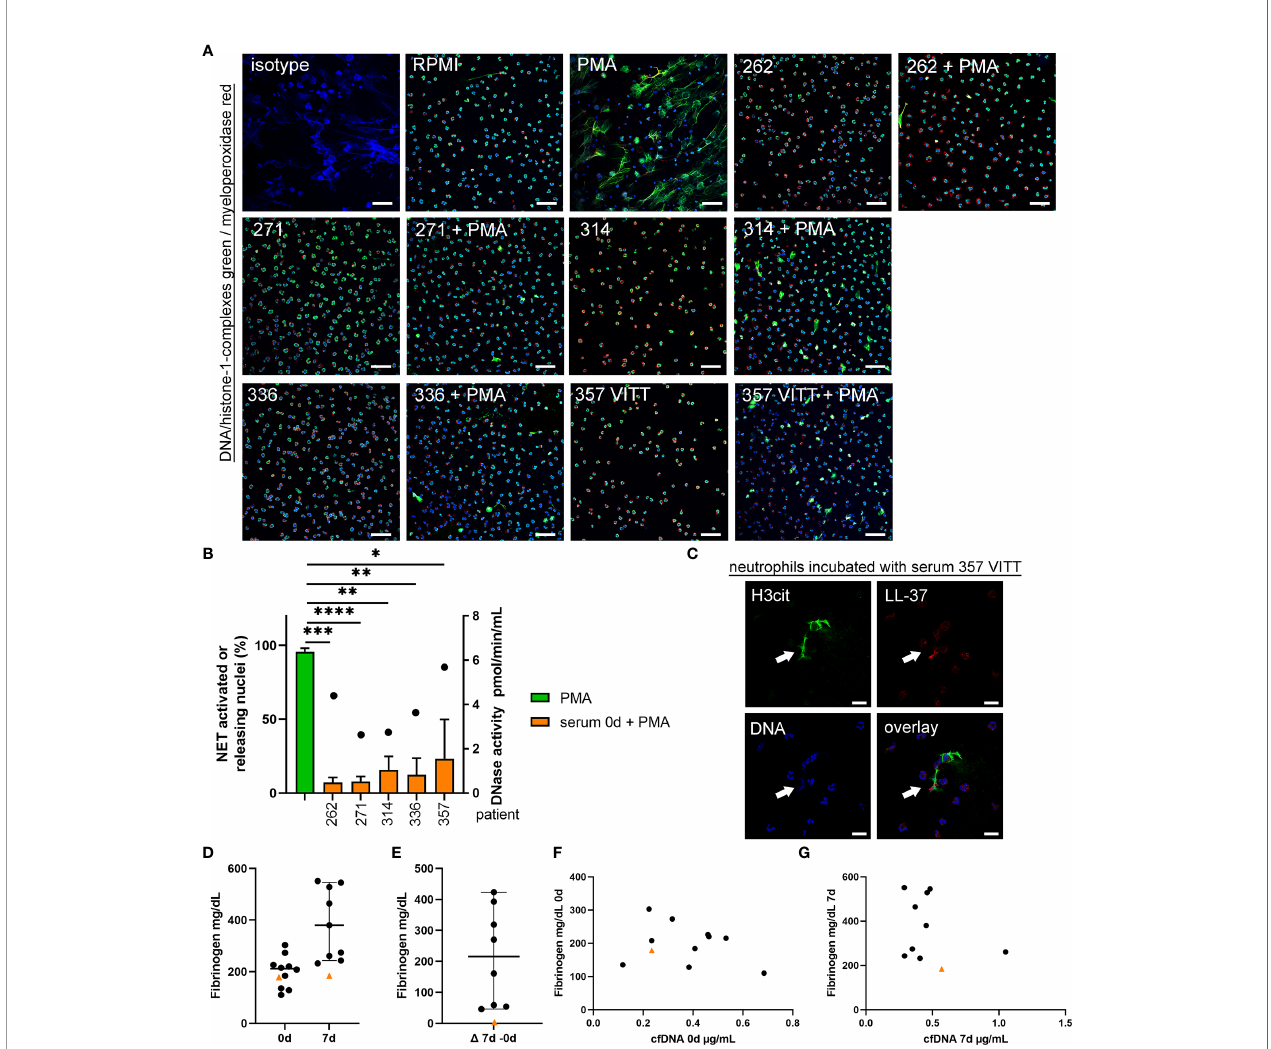
FIGURE 6 | Serum from VITT and control patients does not induce NET-formation, but NET-release from activated neutrophils is less inhibited in VITT-patient. (A) Human blood-derived neutrophils were incubated with serum from onset of four control patients and the VITT-patient in presence and absence of the ROS- dependent NET inducer PMA. Samples were analyzed for NETs (blue = DNA, green = DNA-histone-1-complex, red = myeloperoxidase) by confocal immuno fl uorescence microscopy. The settings were adjusted to a respective isotype control. Representative images (overlay) of all samples incubated with serum, a negative control (RPMI) and a positive control (PMA) are presented. Scale bar = 50µm. (B) In each experiment (n = 3) and for each sample, six randomly taken pictures from two individual slides were analyzed for NET quanti fi cation. All cells on the six pictures were counted and the mean of activated cells per experiment was calculated and used for statistic. Serum samples without PMA stimulation did not induce NETs (See Supplementary data Figure S3 ). In all serum samples the ROS-dependent NET-induction was signi fi cantly reduced. Highest NET-release was detected in the VITT-patient. Data were analyzed with one-tailed paired Student ’ s t-Test calculated always to PMA positive control (presented with mean ± SD (*p ≤ 0.05, **p < 0.01, ***p < 0.001 and ****p < 0.0001). The DNase activity in the analyzed serum samples, as potential NET degrading enzyme, is presented as dot referring to the right y-axis. (C) A representative image is presented, showing an extracellular DNA- fi ber positive for citrullinated histone (H3cit) (green) and LL-37 (red) after incubation of neutrophils in serum from the VITT-patient (Scale bar = 20 µm). (D, E) Fibrinogen is described to inhibit NET release and was analyzed in citrate plasma. All data are presented as scatter plots, black lines depict the median and whiskers depict 95% con fi dence intervals of control values (n = 10). Each dot represents one patient. The VITT-patient is marked as orange triangle. A low value is detected in the VITT-patient, without almost no change (delta) over time (E) . (F) Values of cfDNA and fi brinogen at onset were plotted in one graph. (G) Values of cfDNA and fi brinogen at 7d were plotted in one